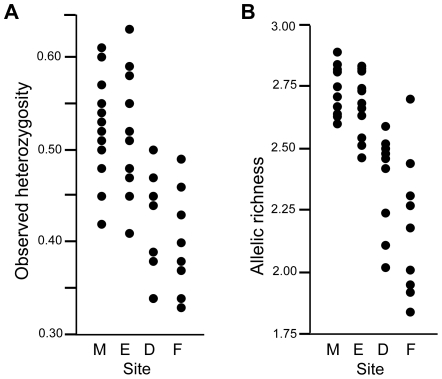
Genetic diversity among sites and locations differs according to colonization sequence.Observed heterozygosity (A) and allelic richness (B) at all 43 locations from four sites.